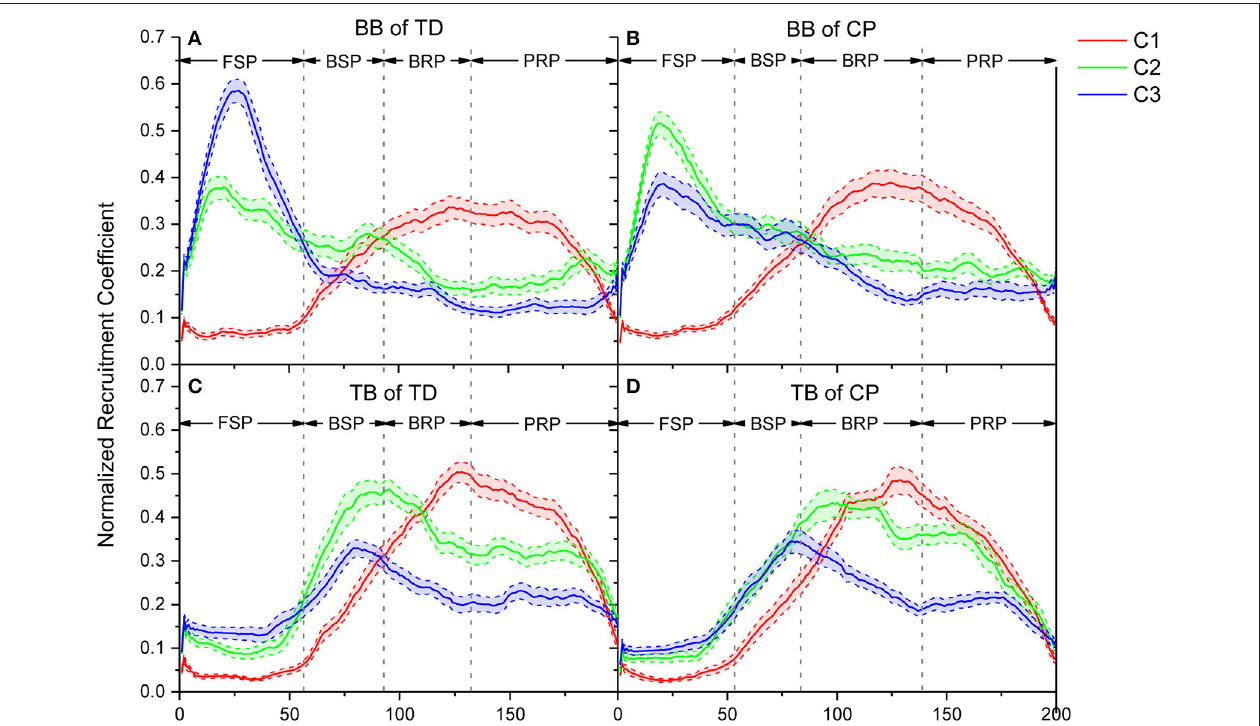
FIGURE 7 | Comparison of recruitment coefficient curves for three sEMG oscillation synergies and their performance in every refined phase for TD and CP group during one crawling cycle. (A) BB of TD group; (B) BB of CP group; (C) TB of TD group; (D) TB of CP group. Red (C1), green (C2), and blue (C3) lines represent the recruitment coefficient curves of synergy1, synergy 2, and synergy 3, respectively.